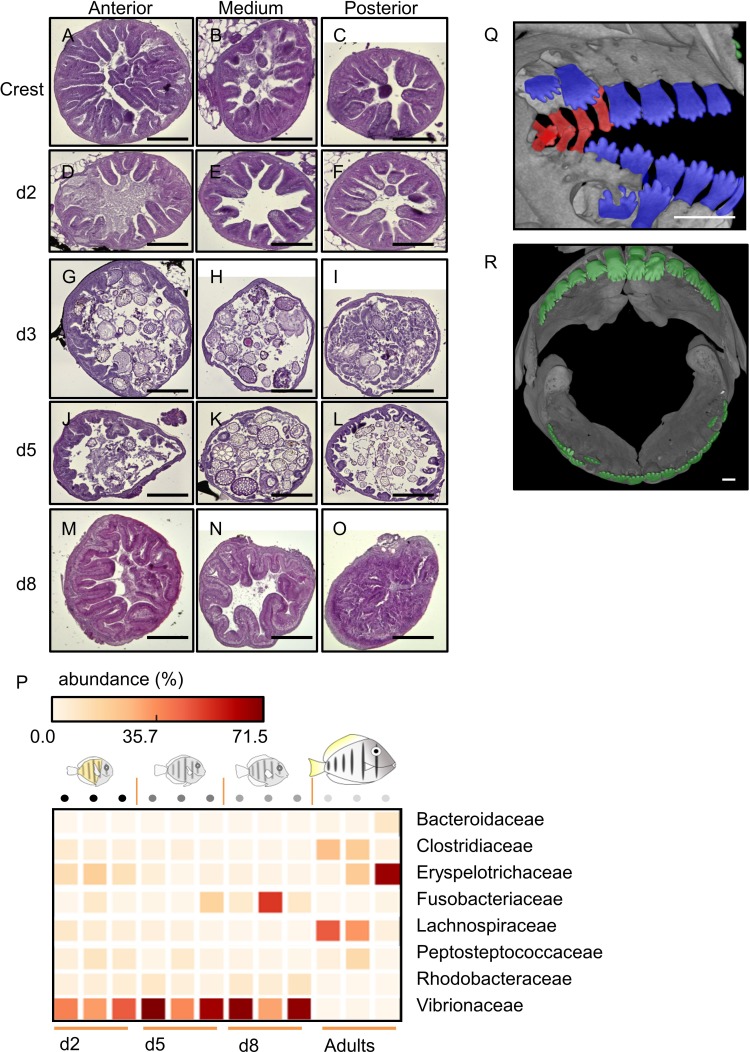
Changes in Acanthurus triostegus intestine and teeth during larval recruitment.(A–O) Complete guts histology of Acanthurus triostegus after reef colonization. First column: anterior part of the intestine (first cm), middle column: medium part (variable), last column: posterior part of the intestine (1 cm), (A–C): crest individual, (D–F): 2 days juvenile, (G–I): 3 days juvenile, (J–L): 5 days juvenile, (M–O): 8 days juvenile. Scale bars represent 200 µm. These pictures are representative of n = 6 section technical replicates for each of the proximal, middle and distal intestine, and were performed twice (sampling technical replicates), on n = 2 fish (biological replicates). (P) Heat map of bacterial gut community. Each column is one individual. Each row is bacterial taxa. Only the taxa with differential representations between the samples are shown. Sampling stages: day 2, day 5, day 8 and adult are indicated below the heat map. The shape of each of this developmental stage is schematized over the heat map. Each column is highlighted by a circle, the difference in shade between the circles emphasizes the stage difference. The color of each square in the heat map is proportional to the abundance of the taxa (row) in the sample (column). (Q) µCT scan of a crest larva, lateral view. Dental family C are highlighted in red and dental family B in blue. (R) µCT scan of an adult, frontal view (mouth open). (Q–R) The scale bar indicates 0.5 mm. These pictures are representative of n = 2 fish (biological replicates).